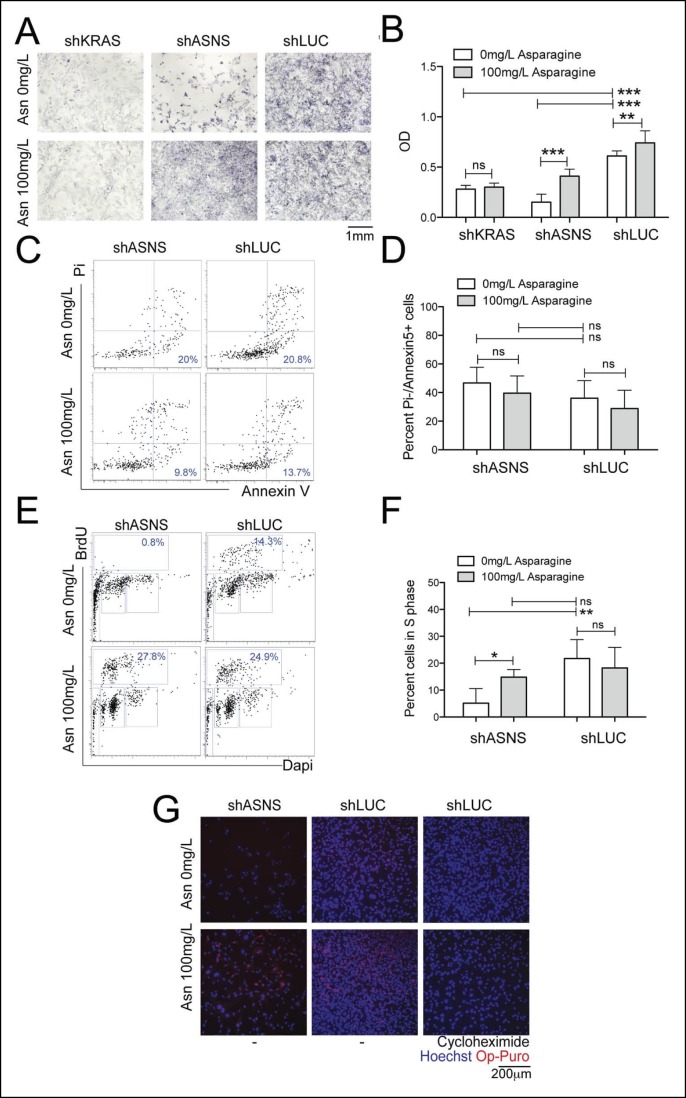
Reduced mouse Kras;p16p19null NMS cell growth after Asns silencing was associated with reduced polypeptide synthesis.(A–B) ShRNA-mediated silencing of Asns and Kras in a mouse Kras;p16p19null NMS cell line reduced proliferation activity compared to shLUC-infected control cells as measured by MTT uptake. Asparagine supplementation (100 mg/L) in the tissue culture medium reversed the anti-proliferative effects of shASNS, but not shKRAS. (C–D) Asns silencing did not change the percentage of PI-/Annexin5+ apoptotic cells. (E–F) Asns silencing reduced the percentage of cells in S phase as determined by BrdU staining, compared to shLUC-infected control cells. This effect was reversed by exogenous Asparagine supplementation. (G) Polypeptide synthetic activity was determined by OP-puromycin staining. Absent OP-puromycin staining in cells treated with cycloheximide (right panels) validated the experimental approach. Asns silencing reduced polypeptide synthesis in Kras;p16p19null NMS cells (top left panel), and polypeptide synthesis was restored in shASNS RMS cells by Asparagine supplementation (bottom left panel) (ns p≥0.05, * p<0.05, ** p<0.01, *** p <0.001; as determined by T-tests).